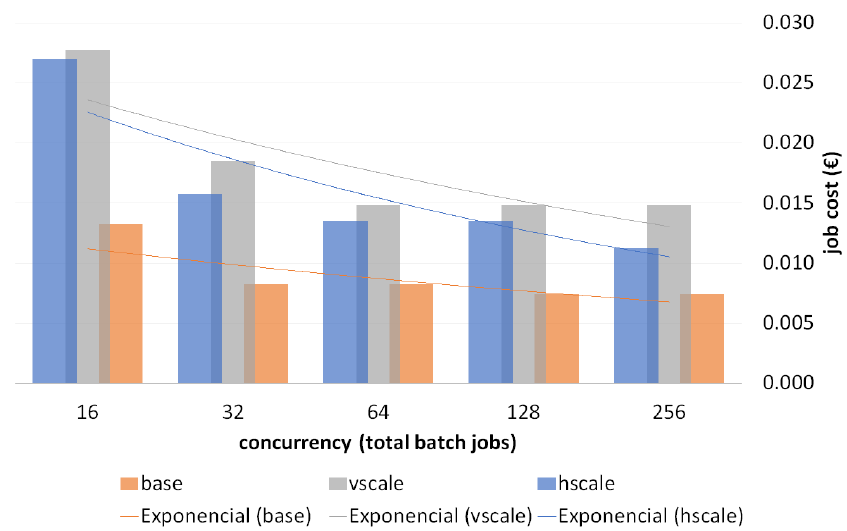
Figure 7. Cost-per-job ( e ), from the effective computation time to complete the execution of a job for each experiment and the cluster cost ( e